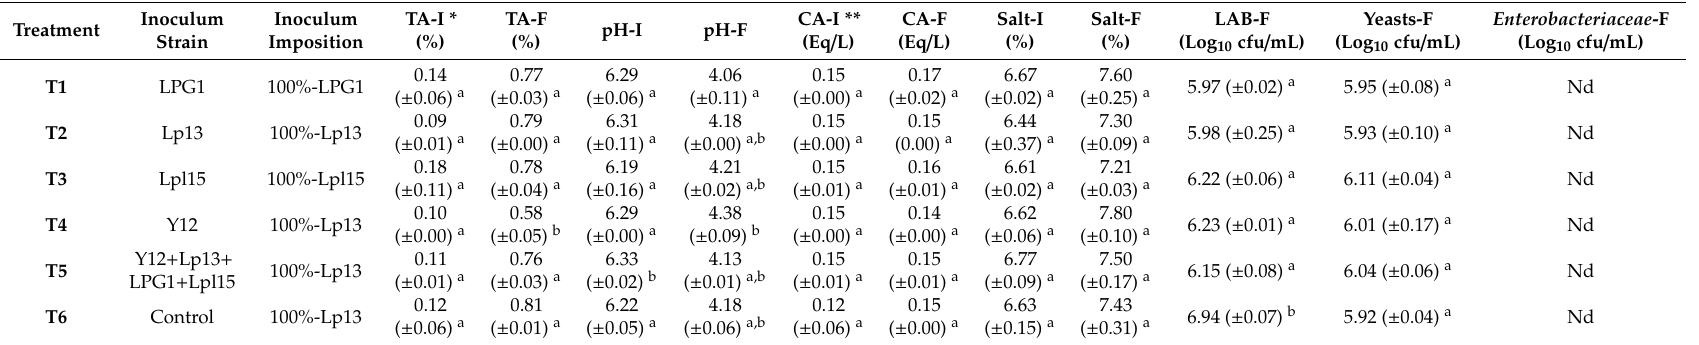
Table 1. Microbiological and physicochemical analysis of the treatments at the moment of LAB inoculation (I, 9 days) and at the end of fermentation (F, 65 days). Inoculum imposition was determined by rep-PCR with GTG 5 primer at 19 days of fermentation. Treatment